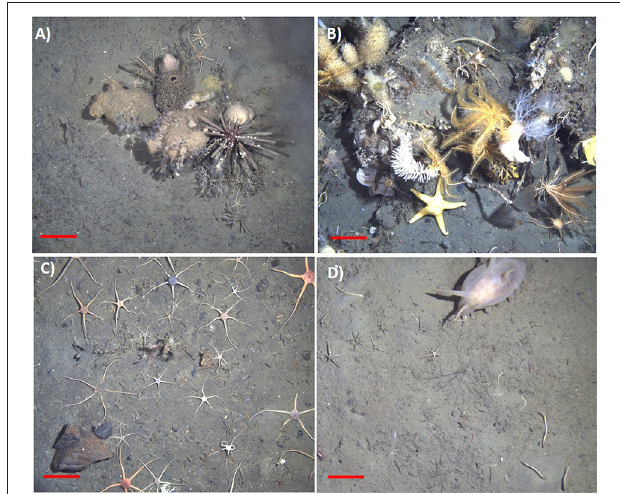
FIGURE 3 | Examples of in-situ SUCS images of common benthic communities and taxa. (A) Biogenic habitat forming taxa including poriferan species and the pencil spine urchin cidaroid, (B) species associated with hard substrata including crinoid species, and suspension feeding dendrochirotid holothurians, cnidarians, and annelids, (C) ophiuroid dominated community (cf. Ophionotus victoriae ), and (D) deposit feeding holothurian Protelpidia murrayi in a mud dominated area. Scale bars represent